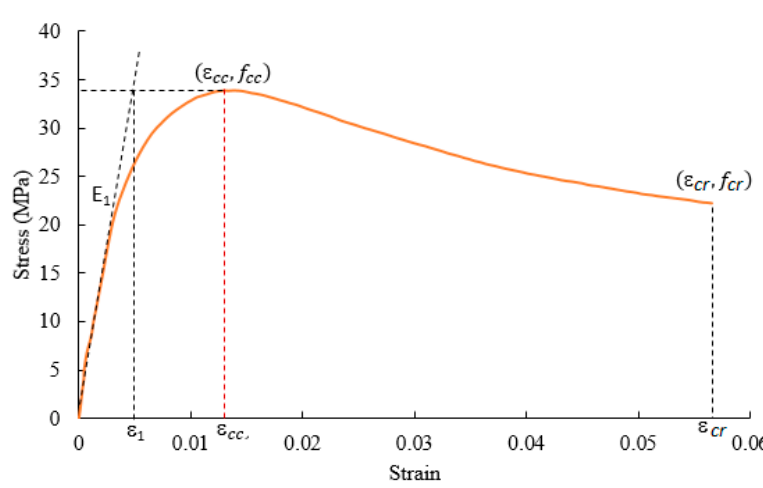
Figure 17. Stress-strain response parameters used to calculate the ductility factor.